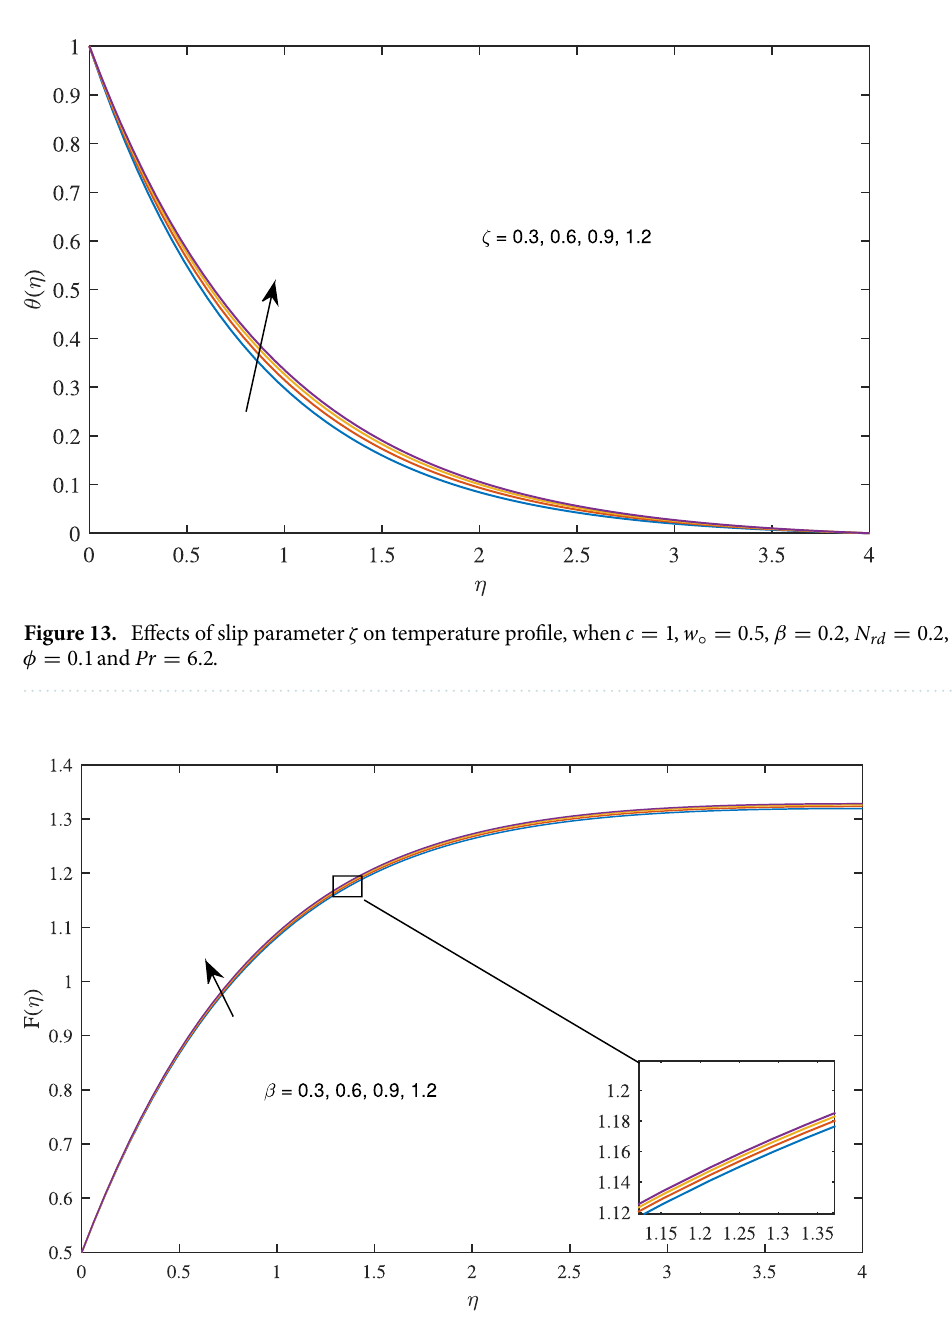
1 , h 0.5 , ζ 0.1 , N 0.1 and 0.2 , φ rd = = = = =